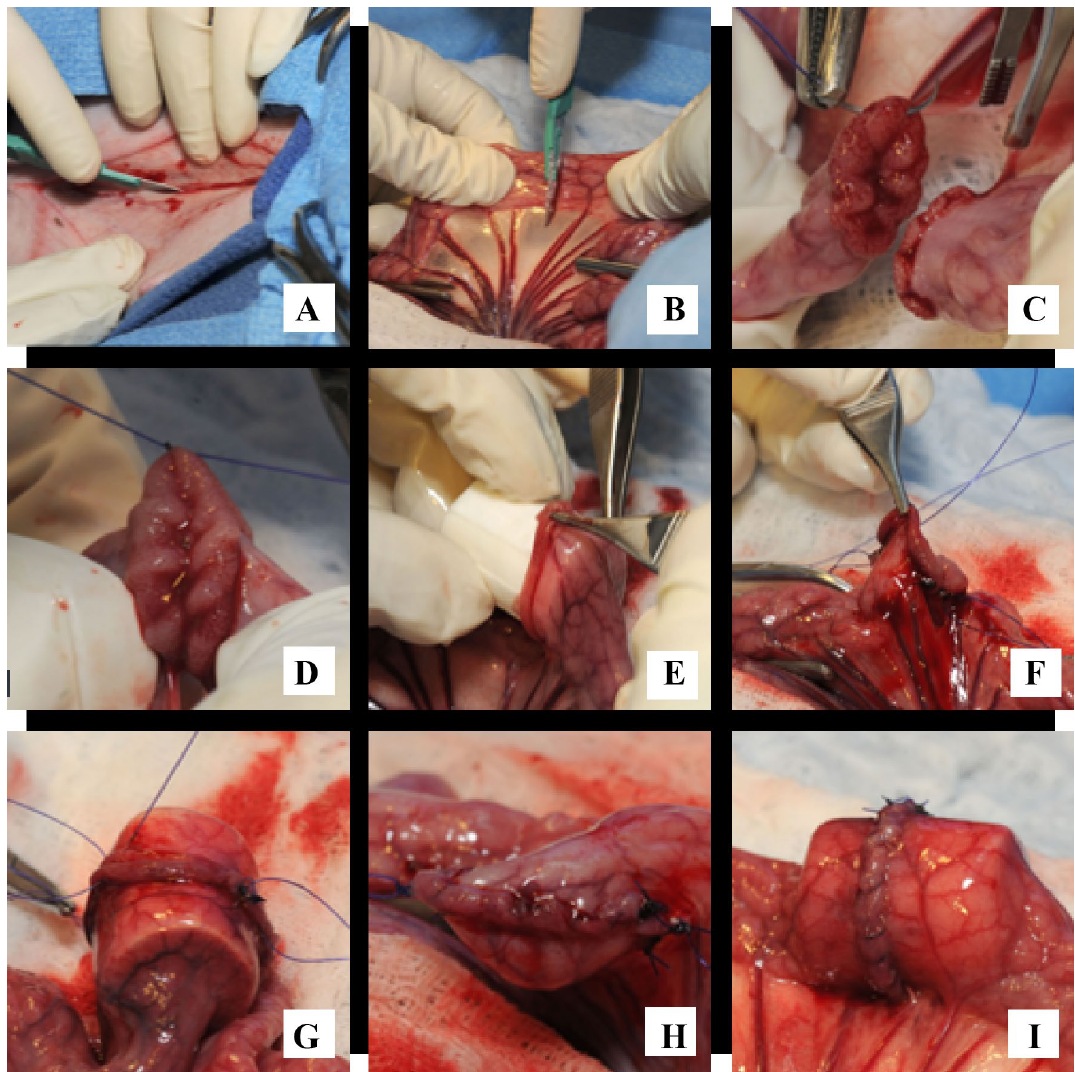
Figure 3. Serial images of surgical process; images pertaining independently to control procedure (“control”) or guide-facilitated procedure (“AG”) are indicated; ( A ) ventral midline incision; ( B ) enterotomy of isolated small intestinal section; ( C ) placement of interrupted suture on mesenteric side (control); ( D ) placement of interrupted suture on anti-mesenteric side (control); ( E ) placement of AG into intestinal lumen (AG); ( F ) completion of anastomosis in absence of AG (control); ( G ) completion of anastomosis overtop AG (AG); ( H ) completed anastomosis in absence of AG (control); ( I ) completed anastomosis with AG in situ (AG). Photo Courtesy of Phil Snow, University of Tennessee, College of Veterinary Medicine. All copyrights retained by University of